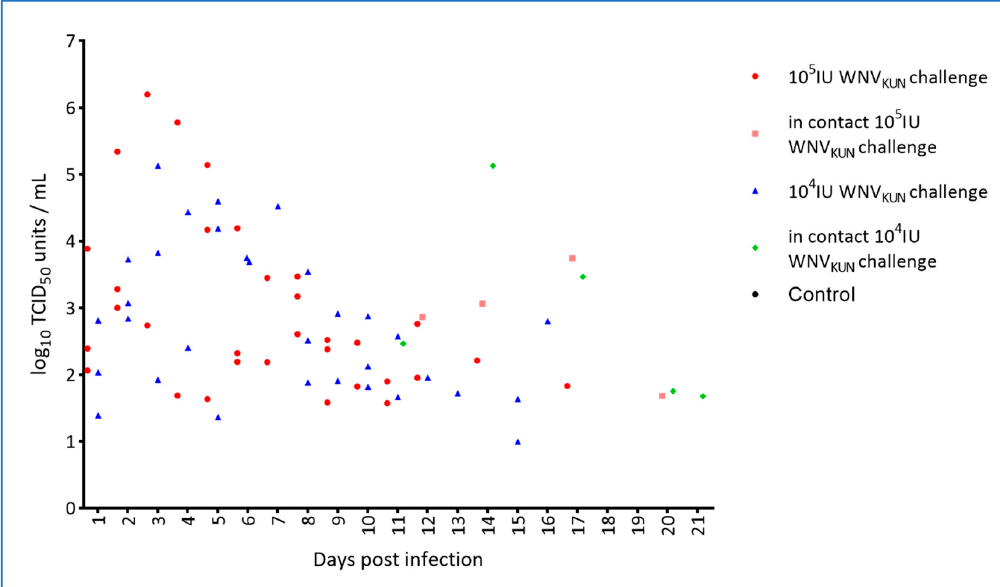
Figure 7. Quantification of WNV KUN RNA in plasma from hatchling saltwater crocodiles following experimental WNV KUN challenge or in-pen contact animals determined by qRT-PCR (limit of detection 10 TCID 50 /mL at Ct = 39; see Figure S1 and Table S4).